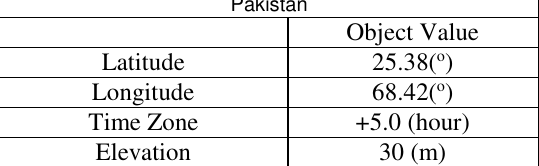
Table 1: Geographical Parameters of Hyderabad, Pakistan